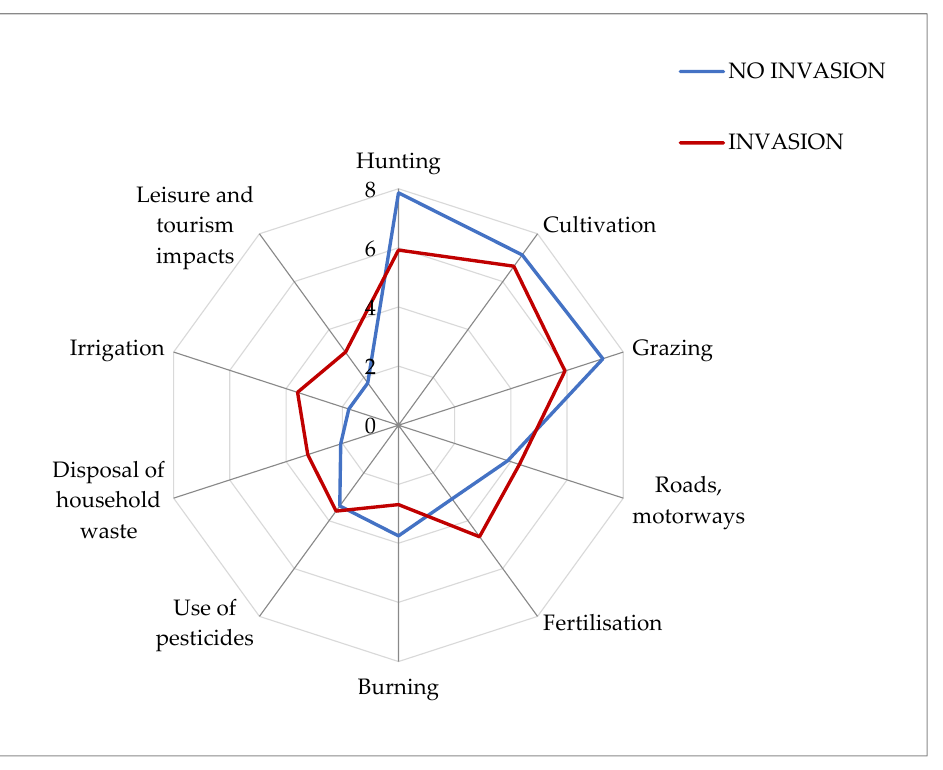
Figure 5. Percentage occurrence of different activities/threats at the investigated Natura 2000 sites of Greece with no invasion (blue) and invasion (red) by Solanum elaeagnifolium (sites with low, moderate, high, and very high invasion are pooled together). Only activities with an occurrence >3% in either invaded or non-invaded sites are shown in the graph.